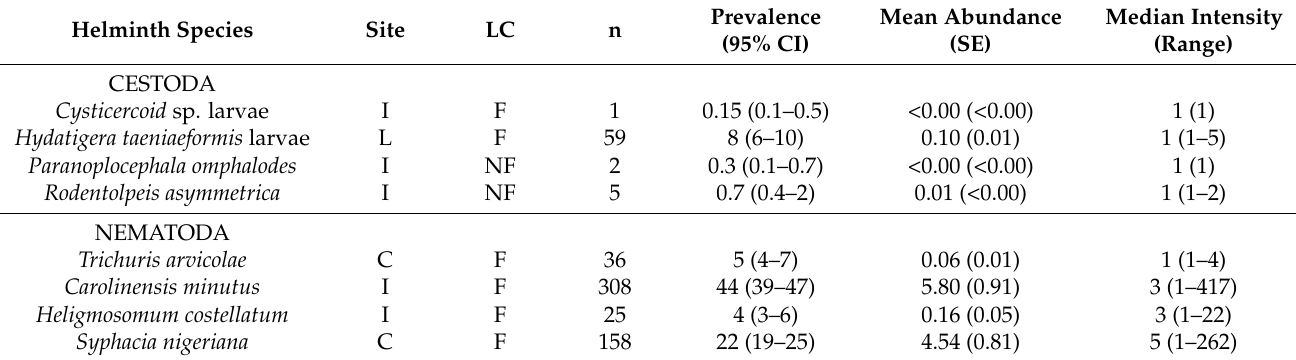
Table 4. Selected characteristics of the helminth community of 710 Microtus lusitanicus analysed.